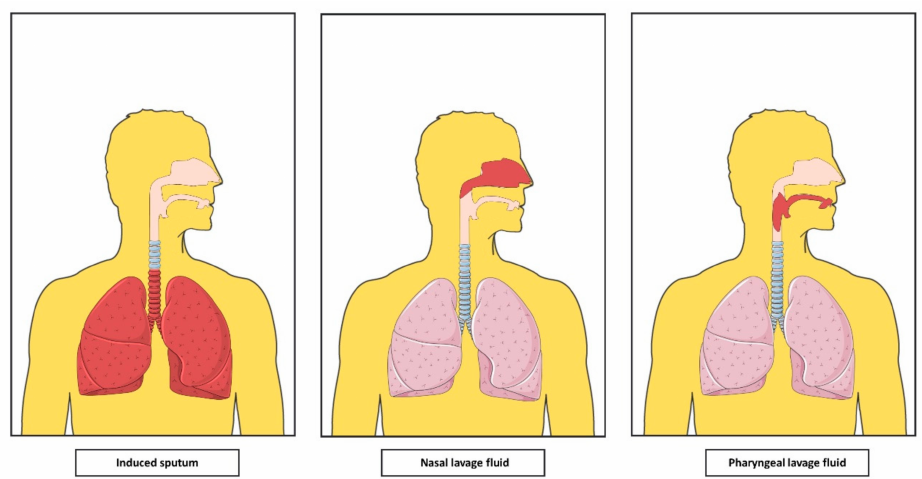
Figure 2. Anatomical origin of minimally invasive and non-invasive airway secretions. Induced sputum comes from lower airway while nasal lavage and pharyngeal lavage have their origin in different parts of the upper airway. (Components of this figure have been obtained and modified from Servier Medical Art, https://smart.servier.com, with permission under the Creative Commons Attribution 3.0 Unported